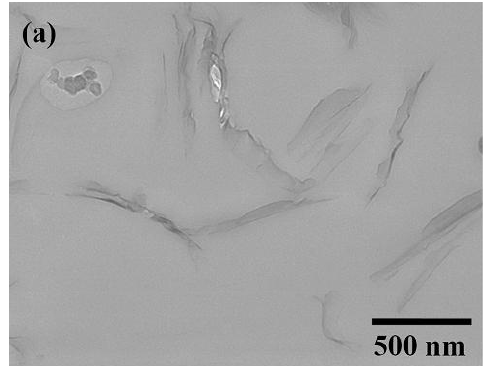
Figure 4. TEM of silicate platelet alignments in cured epoxies; (a) NSP and (b) NMP (reprinted with permission from reference